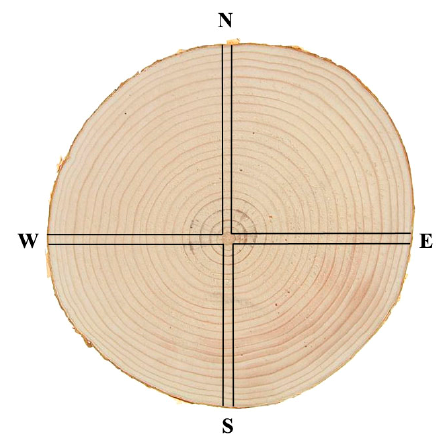
Figure 2. A schematic view of the cores